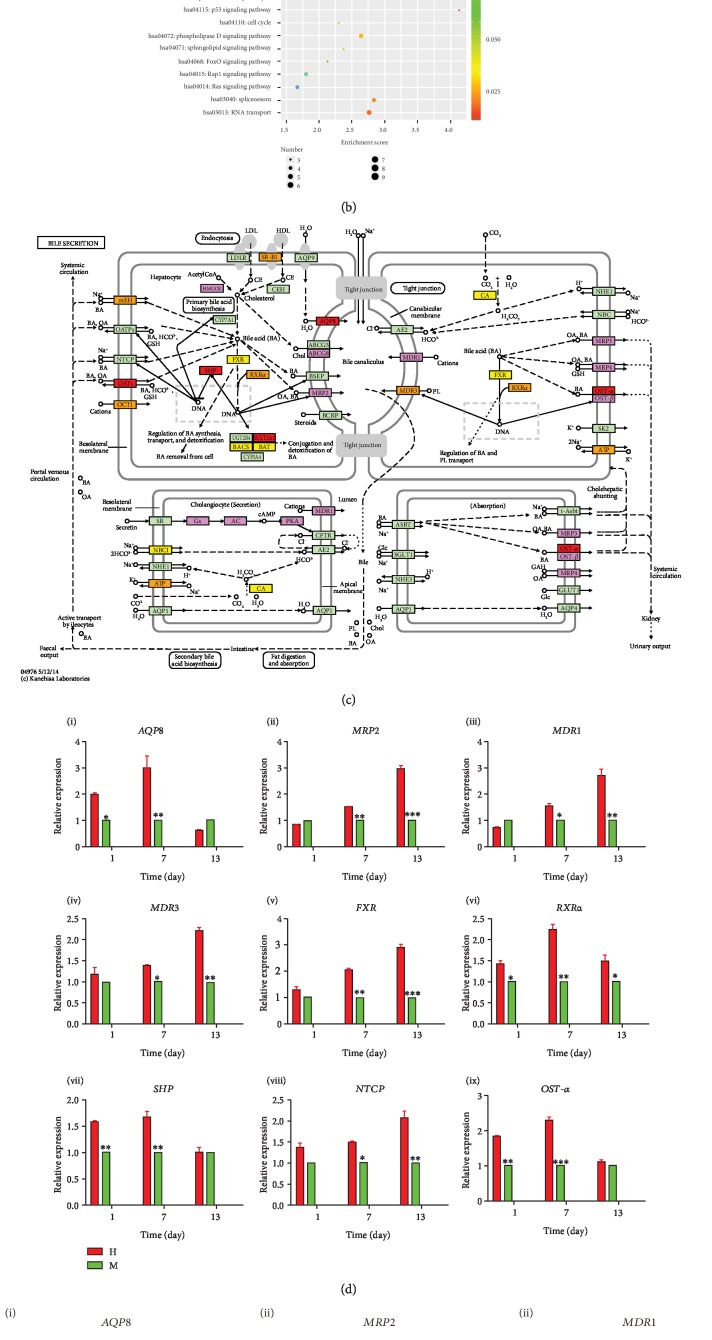
Transcriptome sequencing analysis outcomes. (a) Volcano plots of differentially expressed genes with an absolute fold change > 1.5 (or fold change < 0.667) at different time points in the hepatic plate-mimetic 3D culture group (H) and the mixed 3D culture group (M). Gray and blue colors denote genes without significant differences. Red and green indicate significant upregulated and downregulated genes, respectively. (b) KEGG enrichment bubble charts of the top twenty differentially upregulated genes. Pathways with >1.5 enrichment at different time points in the hepatic plate-mimetic 3D culture group (H) and the mixed 3D culture group (M). H1/M1, Day 1; H7/M7, Day 7; H13/M13, Day 13. (c) KEGG enrichment of the bile secretion pathway for differentially upregulated genes between the hepatic plate-mimetic 3D culture group (H) and the mixed 3D culture group (M) on day 7 with >1.5 enrichment. Red denotes a significant difference; yellow denotes a nonsignificant difference but enrichment >1.5; orange denotes a nonsignificant difference but enrichment > 1.3 or ≤1.5; purple denotes a nonsignificant difference but enrichment > 1 or ≤1.3. BA: bile acids; PL: phospholipids. (d) Differentially expressed genes associated with bile secretion selected from sequencing results and KEGG pathway analysis were analyzed by qPCR. The data represent mean ± SD. Two-way ANOVA: comparison between H and M: ∗P < 0.05, ∗∗P < 0.01, ∗∗∗P < 0.001. H: hepatic plate-mimetic group; M: mixed 3D group. (e) qPCR validation and correlation of expressed genes associated with bile secretion after sequencing and KEGG pathway analysis.